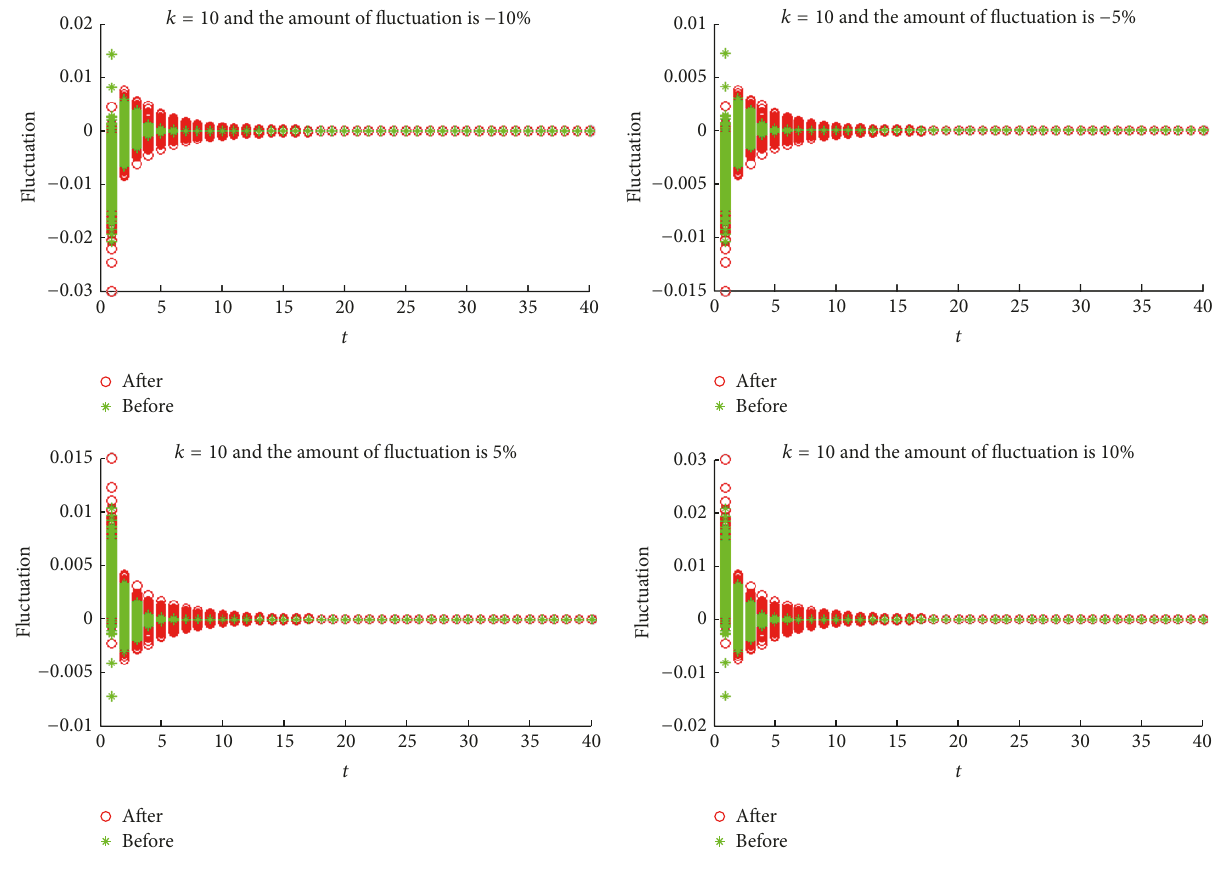
Figure 3: Dynamic evolution of fluctuation in the network when 𝐾 = 10 .